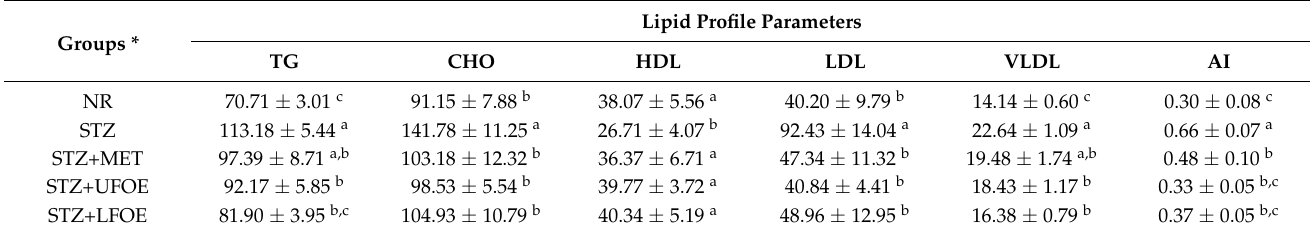
Table 5. Effect of orally administrated fermented oat extract on lipid profile (mg dL − 1 ) and the atherogenic index in Streptozotocin-induced diabetes in rats (mean ± SE), n = 8.